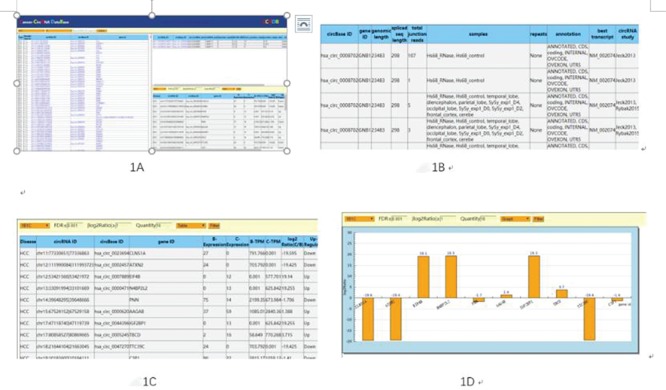
The usage of CCRDB.